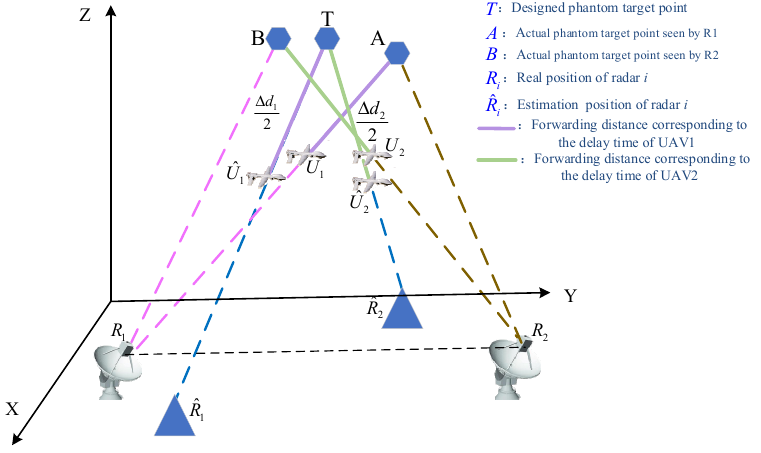
Figure 2. Phantom track model with radar location error and UAV position error.